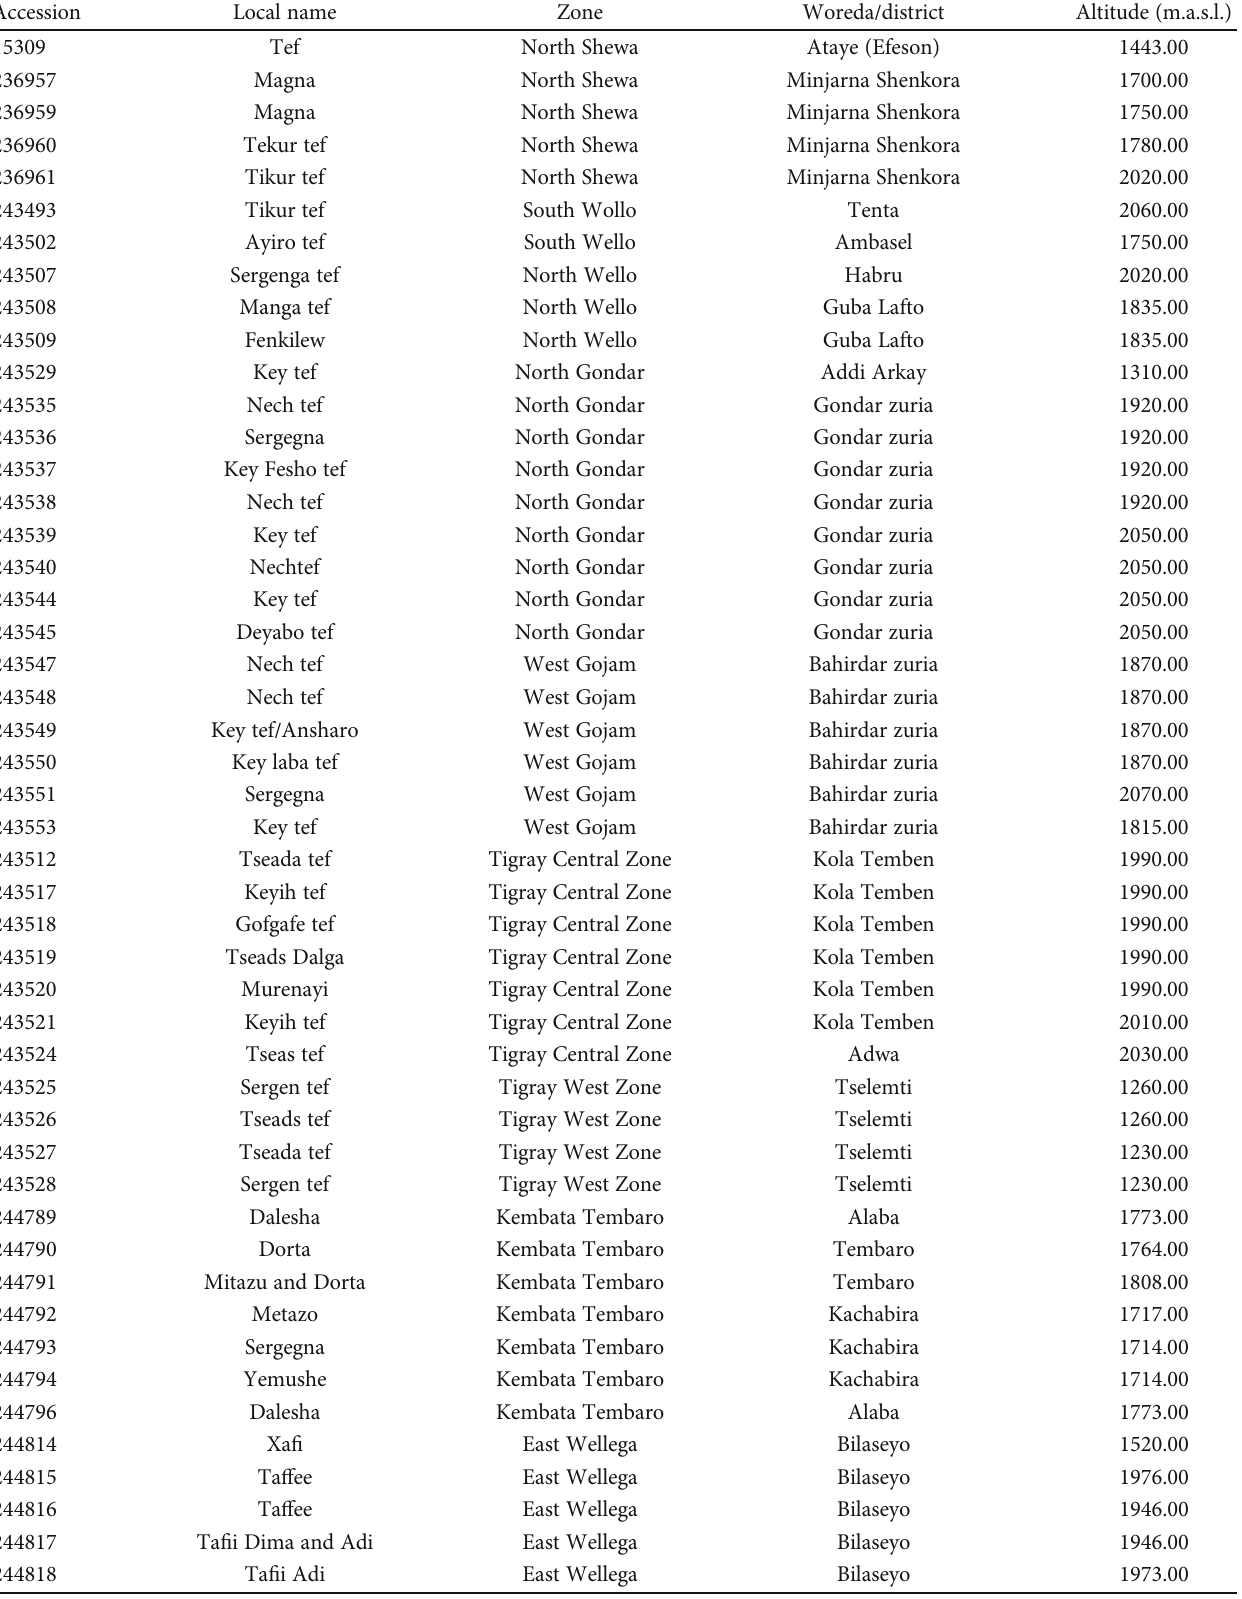
Table 1: Passport data of the tested accessions and their geographical